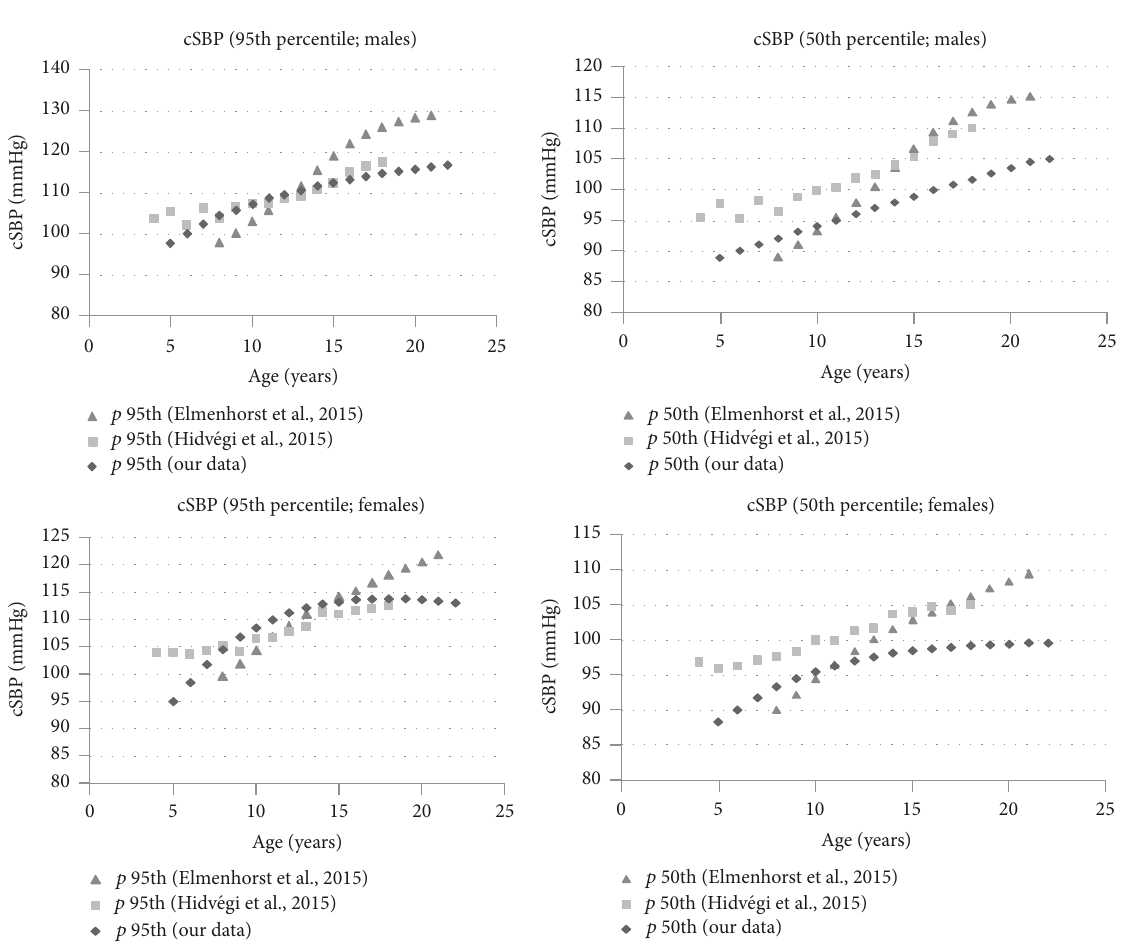
Table A: age-related reference intervals (RIs) for central (aortic) systolic blood pressure for the entire population ( 𝑛 = 1038 ). Table B: age-related reference intervals (RIs) for central (aortic) systolic blood pressure for males ( 𝑛 = 576 ). Table C: age-related reference intervals (RIs) for central (aortic) systolic blood pressure for females ( 𝑛 = 462 ). Table D: age-related reference intervals (RIs) for central (aortic) augmentation index (cAIx) for the entire population ( 𝑛 = 1038 ). Table E: age-related reference intervals (RIs) for central (aortic) augmentation index (cAIx) for males ( 𝑛 = 576 ). Table F: age-related reference intervals (RIs) for central (aortic) augmentation index (cAIx) for females ( 𝑛 = 462 ). Table G: body height-related reference intervals (RIs) for central (aortic) augmentation index (cAIx) for males ( 𝑛 = 576